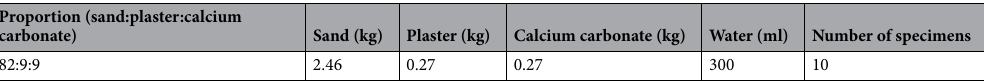
Table 1. Proportion of similar material